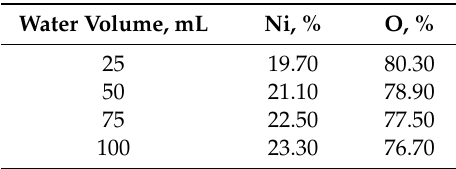
Table 3. Influence of water concentration in the initial mixture on the concentration of nickel and oxygen on the surface of each sample (taken from the survey scan).